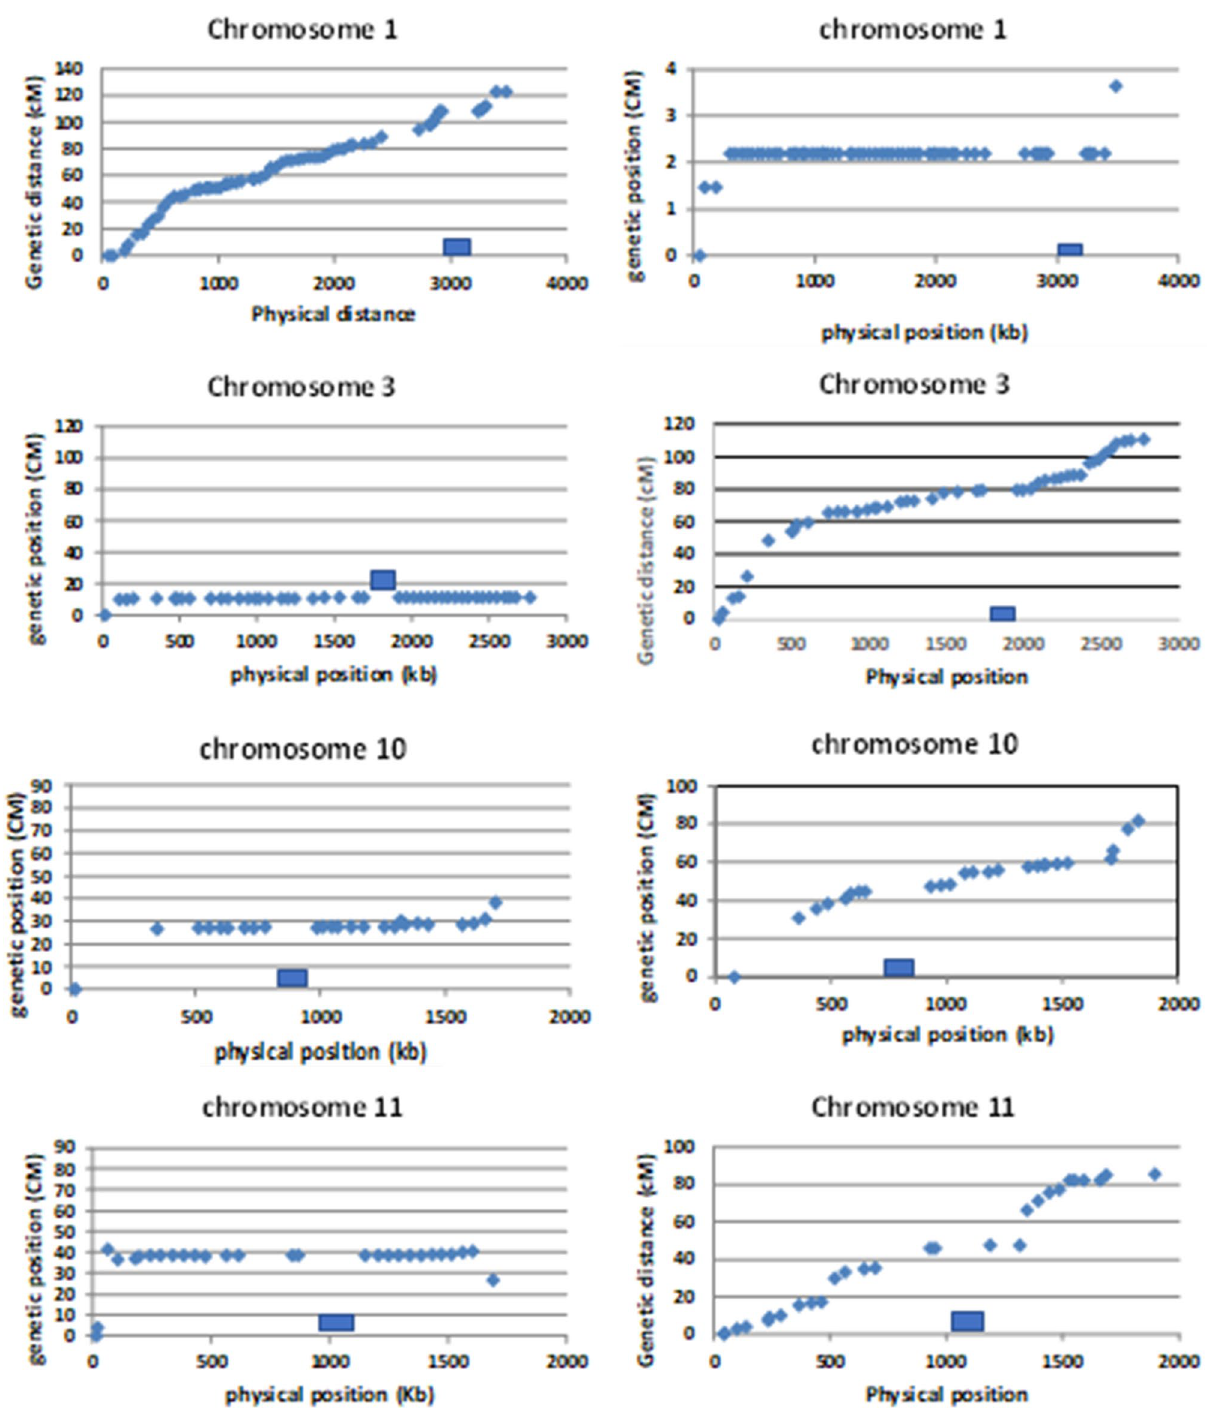
Figure 4. Plots of mapping position (X-axis) of markers against the physical position (Y-axis) for chromosomes 1, 3, 10 and 11 in populations derived from a var. bisporus offspring (left column) and the var. burnettii offspring (heterokaryon 119; right column). The putative location of the centromere (LRC) on each chromosome is indicated as a blue bar. The plots were generated using Excel (Microsoft Office